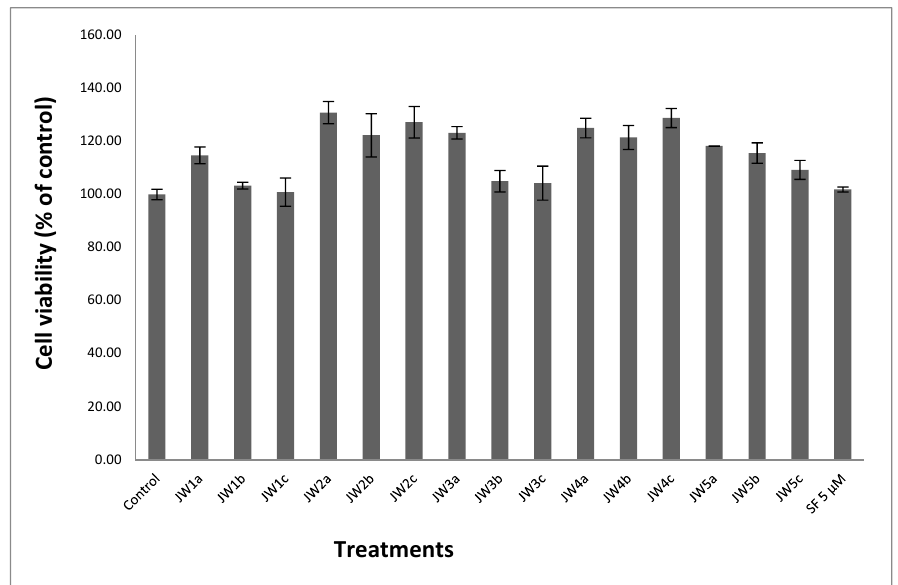
Figure 6. Evaluation of cytotoxicity activity of five fractions in ARE reporter-HepG2 cells. Cells were seeded in 96-well plates at a density of 4 × 10 4 cells/well and incubated for 24 h. The cells were further treated with 20, 40, 80 μ g/mL concentrations of each fraction for additional 24 h. The negative control cells were treated with 0.2% DMSO cells. Cell viability was estimated with the methylthiazoltetrazolium (MTT) assay. Mean cytotoxicity activity represents the average of three-independent experiments ± S.E.M. ( a : 20 μ g/mL; b : 40 μ g/mL; c : 80 μ g/mL).